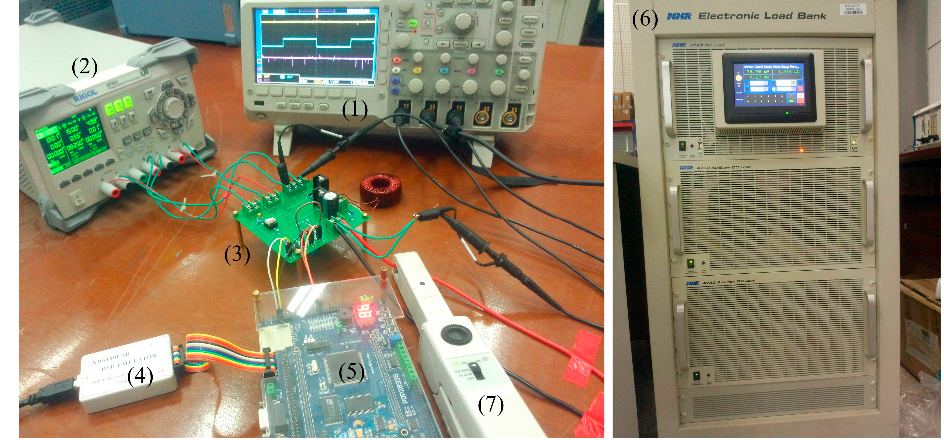
Figure 5. Experimental setup of DC ‐ DC buck converter. ( 1 ) Oscilloscope; ( 2 ) Power supplies for the driver, current sensor and converter; ( 3 ) DC ‐ DC buck converter; ( 4 ) Emulator; ( 5 ) DSP board; ( 6 ) Electronic load; ( 7 ) Current probe.